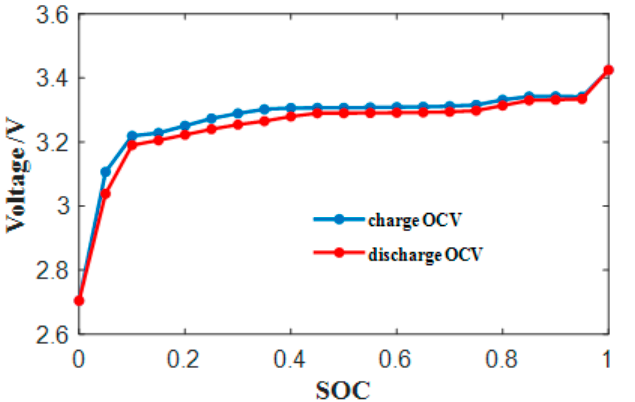
Figure 2. OCV-SOC Characteristic curve.